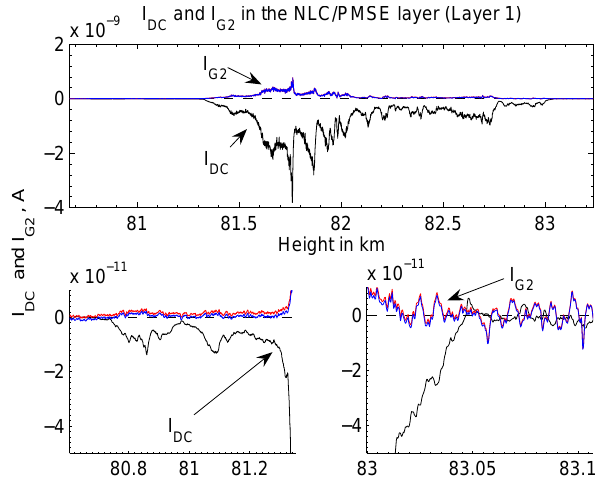
Fig. 4. The corrected I DC (black curves) and I G2 with Fourier correction (red curve) and sinus correction (blue curve) for the NLC/PMSE layer.